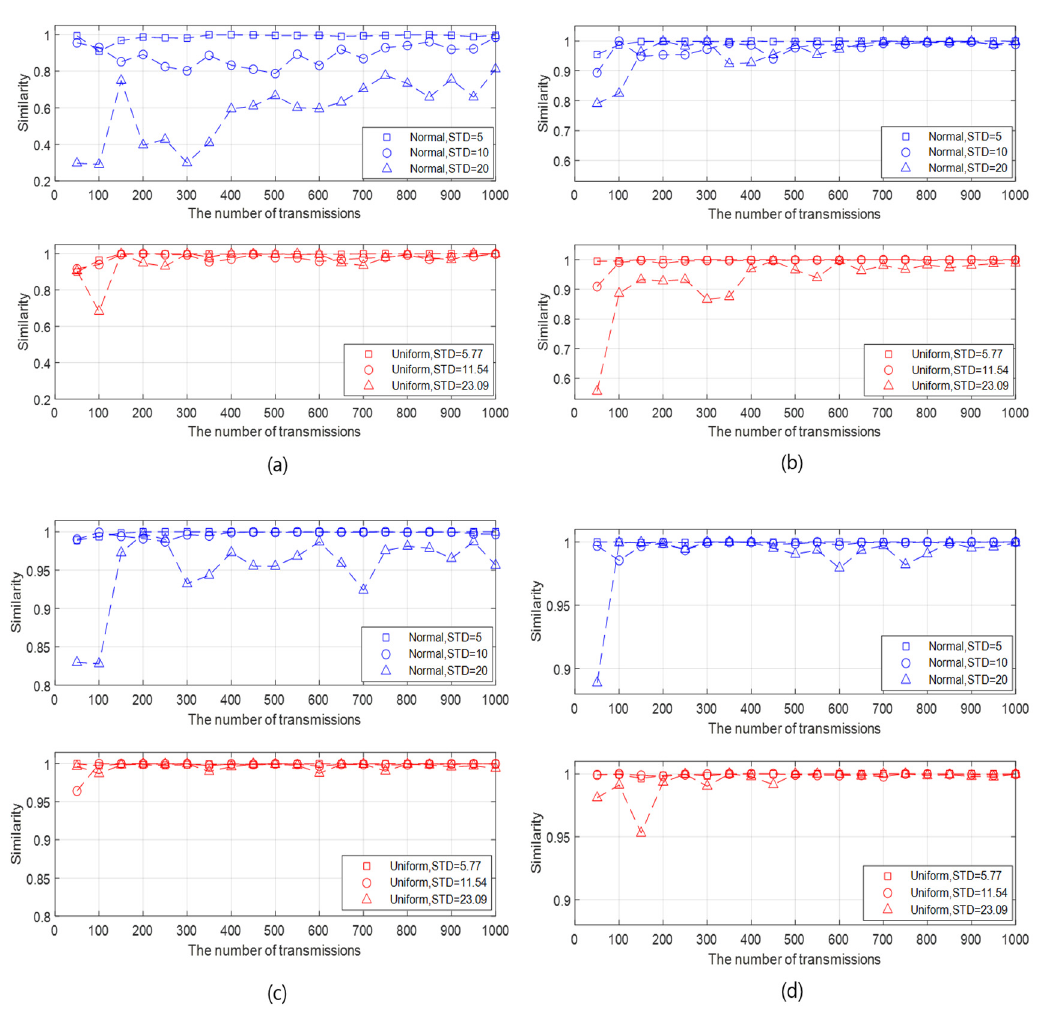
Figure 4. Similarities according to the number of transmissions for different data type, initialization rate, and STDs when the BER is 10 − 3 and the number of slave nodes is 30. ( a ) Initialization rate = 10%, ( b ) Initialization rate=30%, ( c ) Initialization rate = 50%, and ( d ) Initialization rate = 70%.